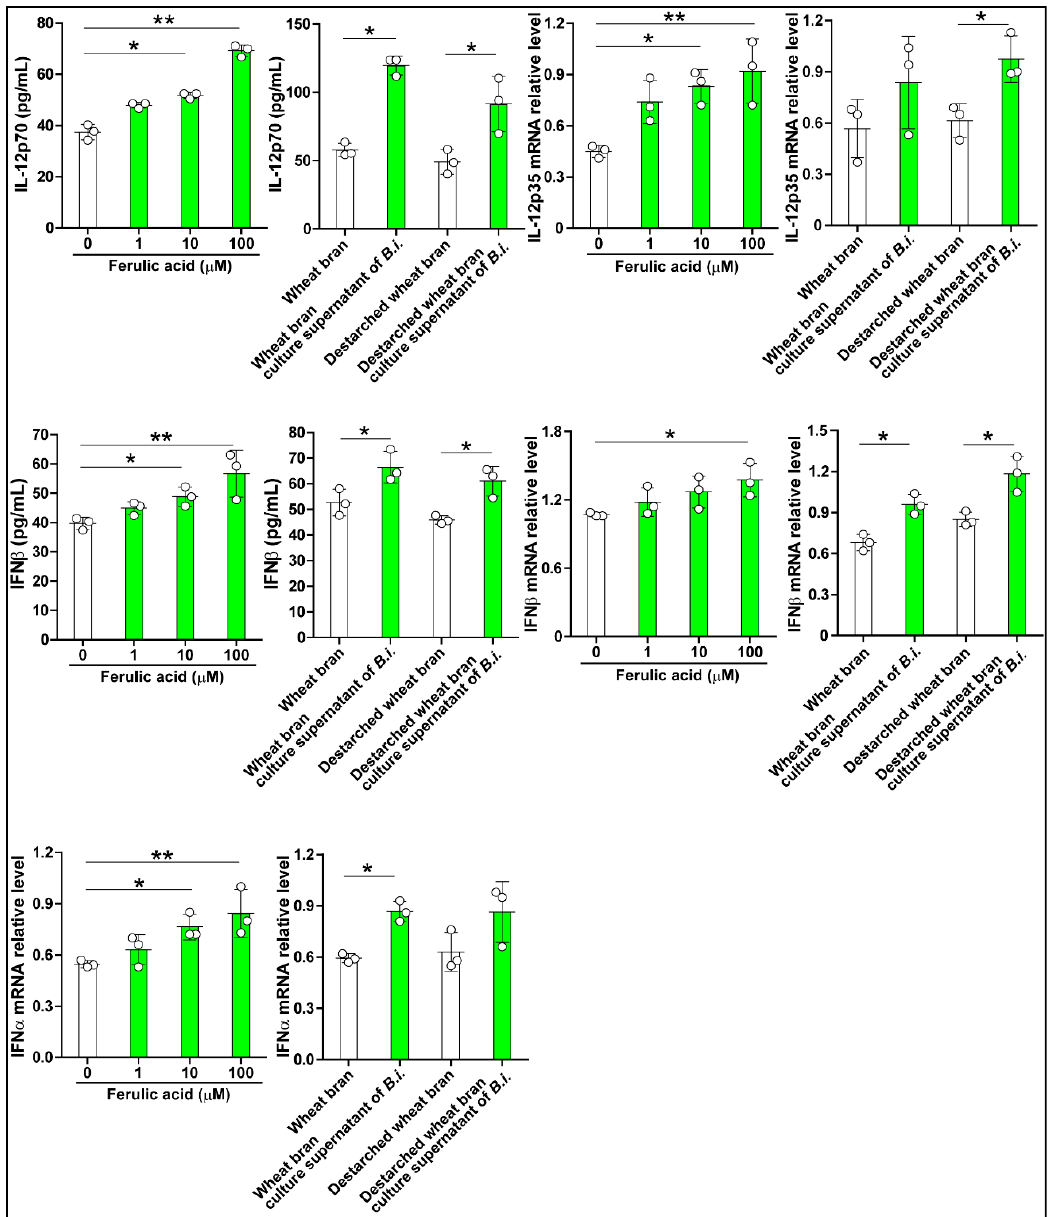
Figure 5. Bacteroides intestinalis culture medium modulated cytokine expression in Caco-2 cells. Culture medium from Bacteroides intestinalis grown in wheat bran and destarched wheat bran increased the production of cytokines as demonstrated by RT-PCR and enzyme immunoassays. Ferulic acid in three concentrations (1, 10, and 100 µM) was used as a positive control. N = 3 in each treatment group. Data are the mean ± S.D. Results from one representative experiment of two independent experiments are shown. Statistical analysis was performed using the Kruskal–Wallis analysis of variance with Dunn’s test and the Mann–Whitney U test. * p < 0.05, ** p < 0.01.